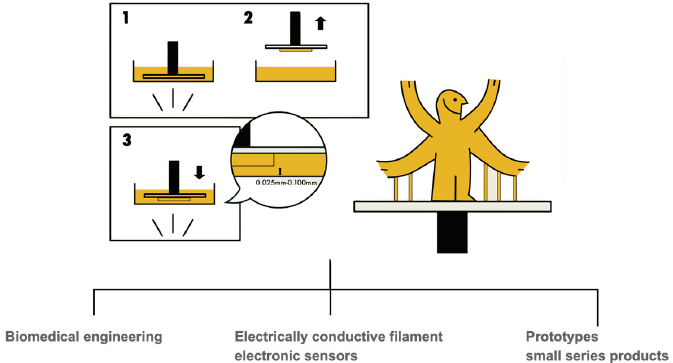
Figure 1. The application of acrylated polymers for additive manufacturing.